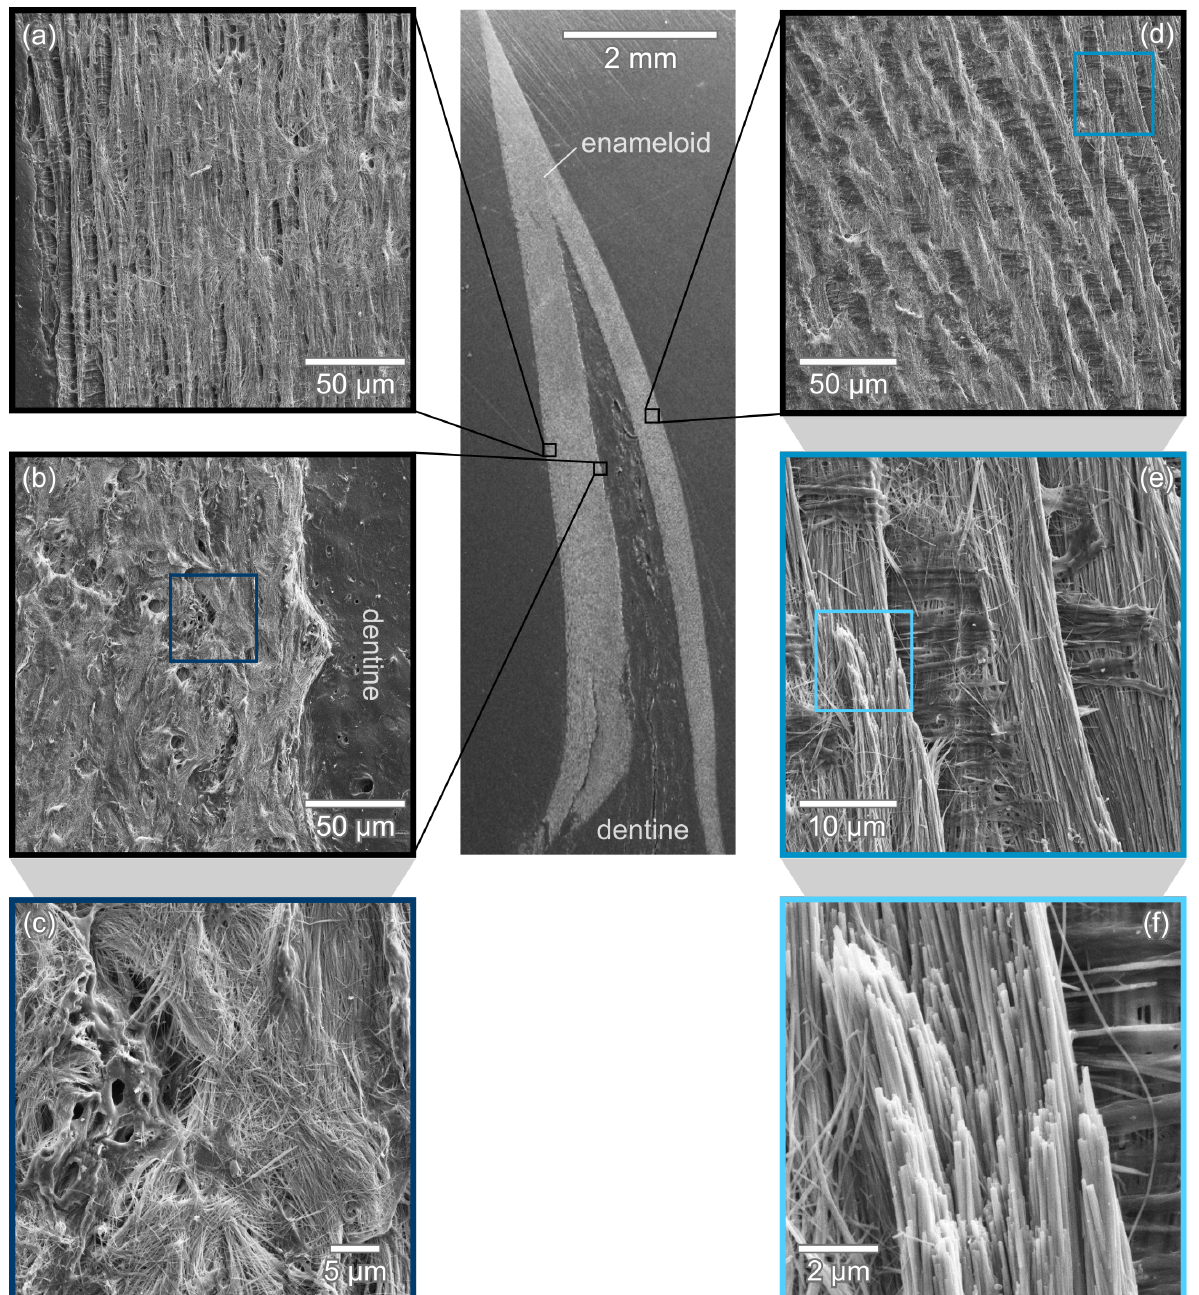
Figure 6. C. taurus tooth in longitudinal section. In the area imaged in ( a ), parallel bundle enameloid (PBE) reaches all the way to the outer surface which is obscured by embedding material. ( b , c ) show three-dimensionally entangled bundles belonging to the TBE close to the dentine. ( d – f ) show a sequence of images with increasing magnification into the PBE in the outer range of the inner enameloid. Between the bundles, remnants of layers between the bundles are visible. An individual bundle ( f ) consists of densely packed, parallel aligned